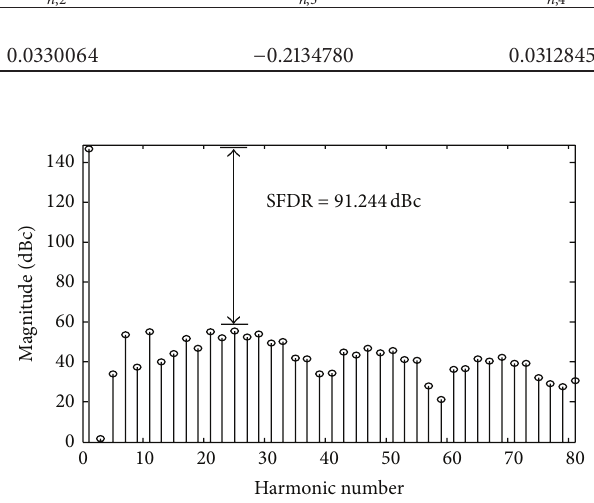
Figure 3: SFDR upper bounds of the hybrid polynomial approxi- mation versus 𝛽 .